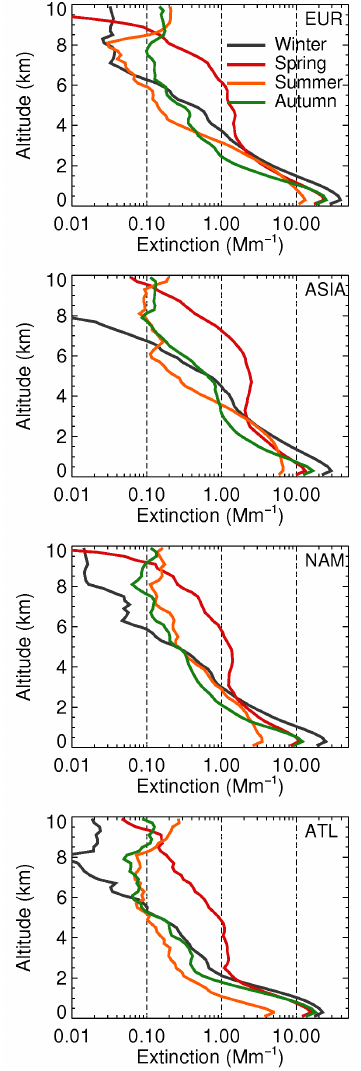
Fig. 11. Mean seasonal vertical profiles of CALIOP nighttime- equivalent extinction for the four Arctic sectors poleward of 65 ◦ N (from top to bottom): European, Asian, North American, Atlantic.